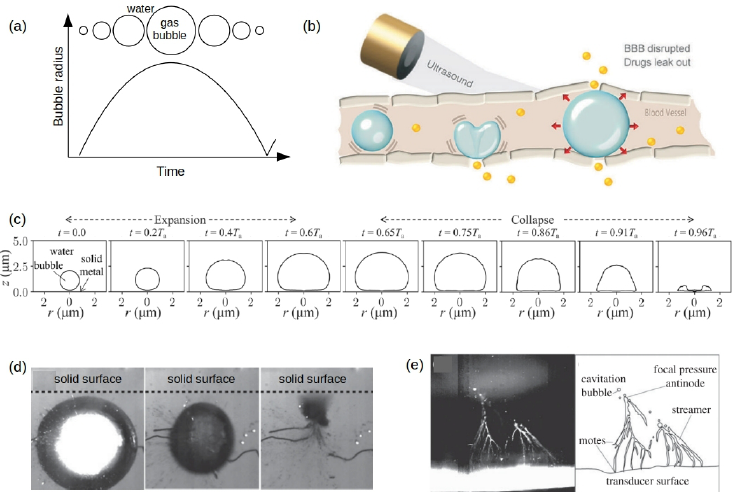
Figure 1. Illustration of bubble oscillation in the bulk of water and near a surface such as the wall of a blood vessel discussed in Section 1. Similar behaviour is observed when a bubble interacts with the wall of an individual biological cell (e.g., [32]). ( a ) Schematic radius-vs-time diagram for a bubble oscillating in the bulk of water. Bubble shapes at different times are shown above the curve during a single oscillation cycle. The pressure inside a bubble is high at the beginning and at the end of the oscillation cycle and is low in the middle. ( b ) Illustration of the principle of drug delivery through the blood-brain barrier (BBB) using bubbles trapped inside a small blood vessel of the brain. Bubble oscillations are driven by an external ultrasound wave transducer and the drug (small spheres in the picture) pass through the wall of a blood vessel when the bubble either reaches its maximum radius or collapses and forms a water jet. Reproduced from [10] under the terms of a Creative Commons license. ( c ) Representative computational axisymmetric profiles of a microbubble during its expansion and collapse near a solid surface. Parameter T a is the period of the sinusoidal acoustic pressure wave with f = 1.5MHz. The pressure wave incident along the z -axis towards the surface has the amplitude of 200kPa. Reproduced from [33] under the terms of a Creative Commons license. ( d ) Experimental observation of a bubble collapse. The first frame shows the bubble at its maximum radius. The bubble shrinks and moves towards the boundary in the second frame and then it collapses forming a jet directed towards the surface. ( e ) Experimental observation of bubble streams that originate mostly from the surface of a transducer and move towards the focal point near the top of the left image. A schematic of a streamer trace (the right image) shows how bubbles emerge from the motes–the source of the streamers. Reproduced with permission of The Royal Society (UK) from [34]. Copyright